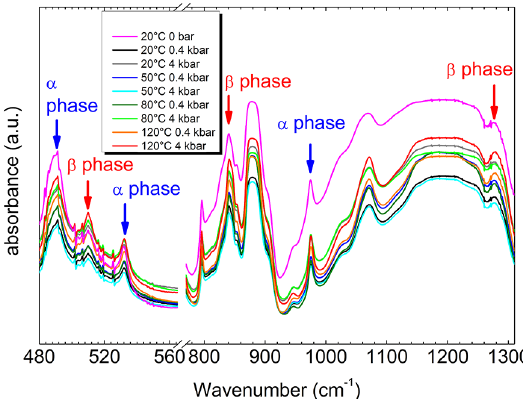
Figure 1. Infrared absorption spectra of the PVdF-CTFE 10 % membranes. The inset indicates the temperature and pressure at which the hot pressing process was